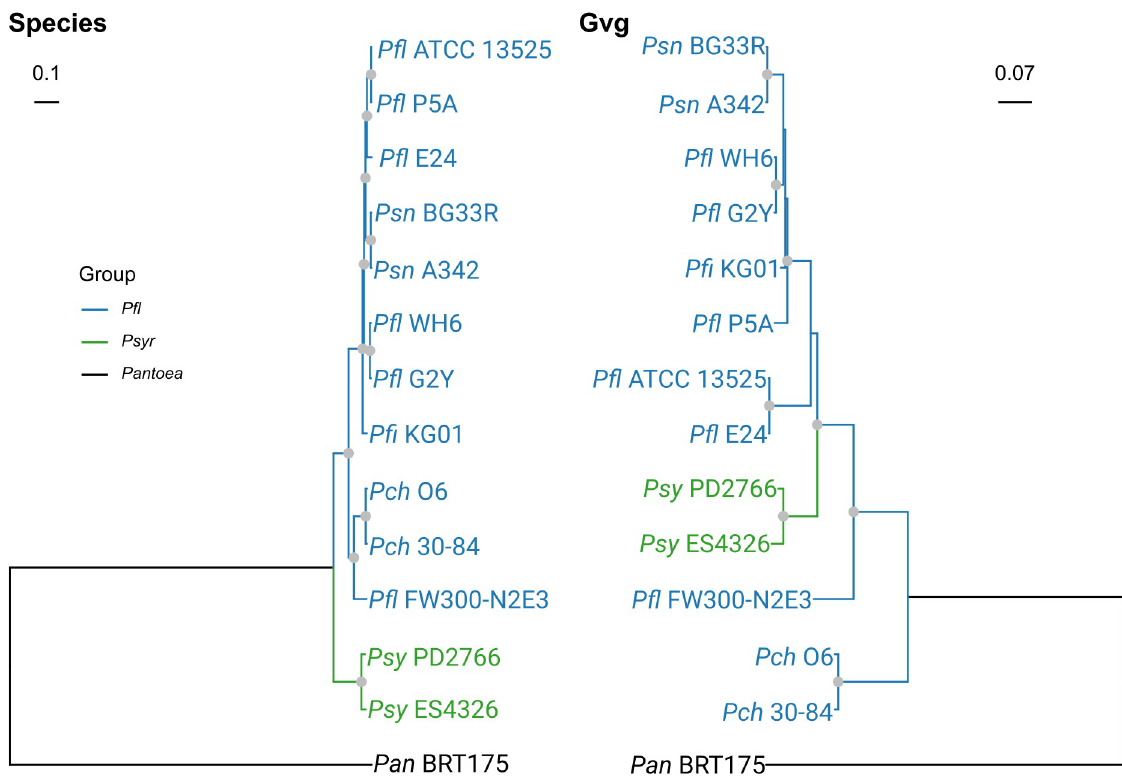
Fig 4. The Pseudomonas species and Gvg trees are incongruent. Trees were generated using maximum likelihood analysis. The species tree was inferred from the amino acid sequences of 99 housekeeping genes, while the Gvg tree was generated using a partitioned analysis of seven of the Gvg protein sequences. The trees were rooted to Pantoea ananatis BRT175. Nodes indicated with a gray circle are well supported ( > 95% UF-bootstraps & > 80% SH-aLRT replicates). Pan , Pantoea ananatis ; Psy , Pseudomonas syringae ; Pch , Pseudomonas chlororaphis ; Pfl , Pseudomonas fluorescens ; Pfi , Pseudomonas fildensis; Psn , Pseudomonas synxantha .